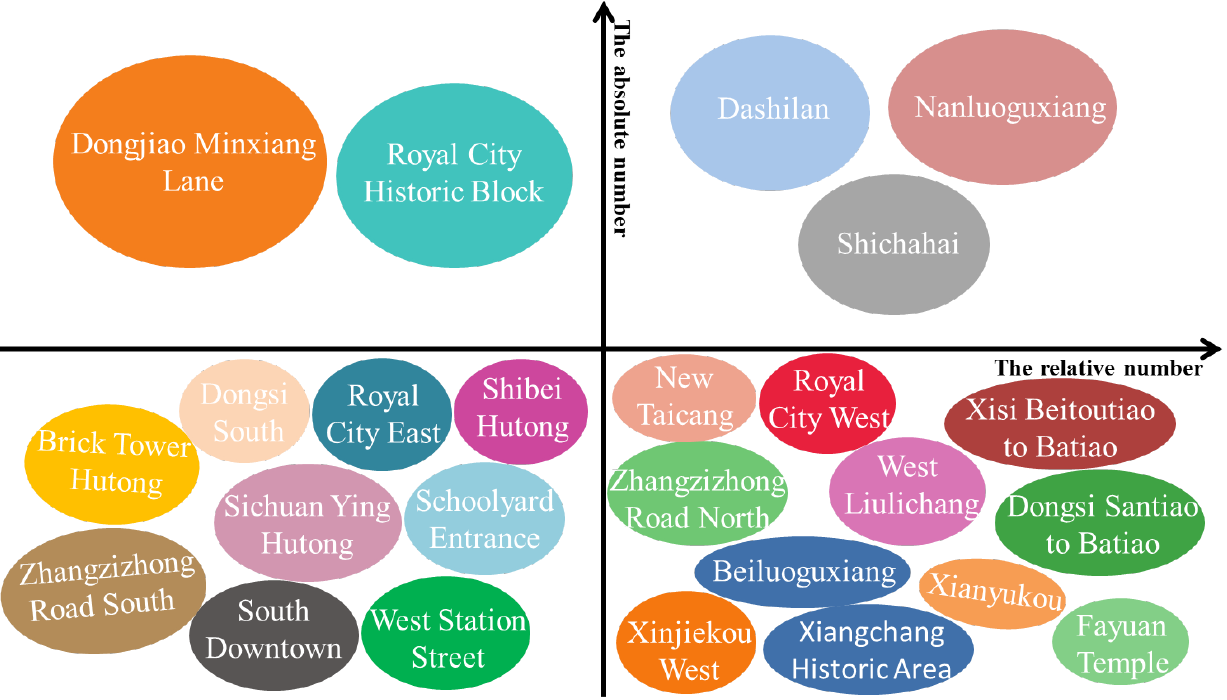
Figure 5. Four-quadrant classification of absolute and relative number of Beijing-style culture.